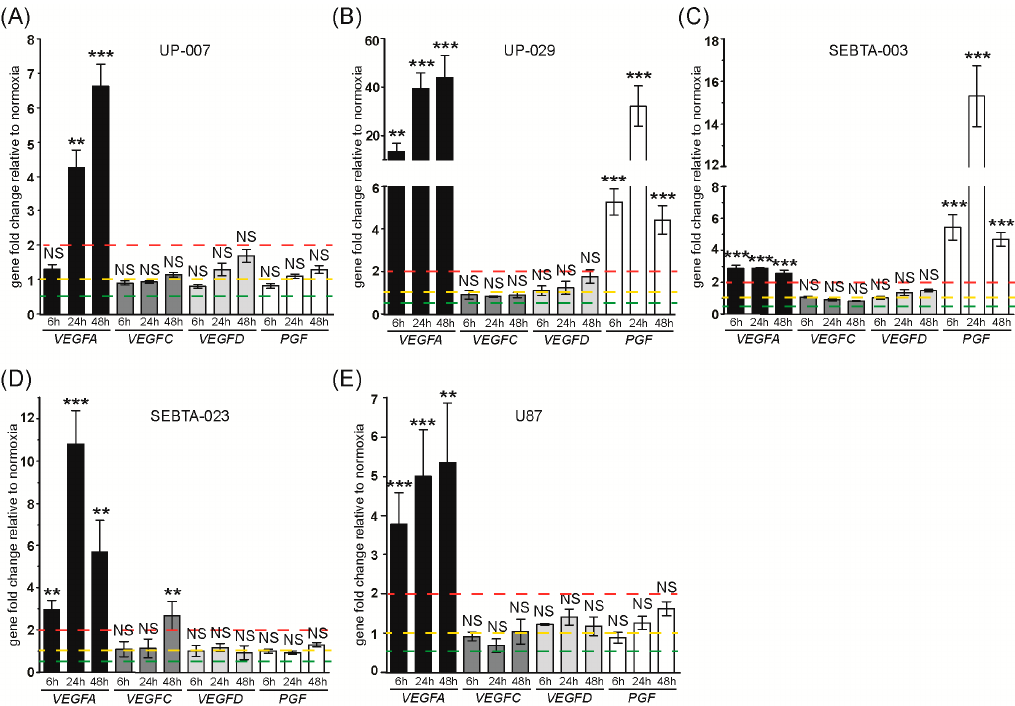
Figure 4. Analysis of angiogenic genes in hypoxic GB cells. ( A ) UP ‐ 007; ( B ) UP ‐ 029; ( C ) SEBTA ‐ 003; ( D ) SEBTA ‐ 023, or ( E ) U87 cells were incubated under normoxia (21% O 2 ) or hypoxia (1% O 2 ) for the times indicated. RNA extraction was performed and gene expression was determined by RT ‐ qPCR.